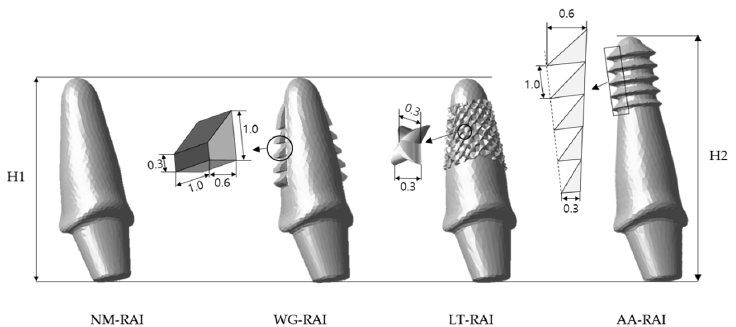
Figure 1. Four modified root analogue implant (RAI) designs of each experimental group. Dimensions